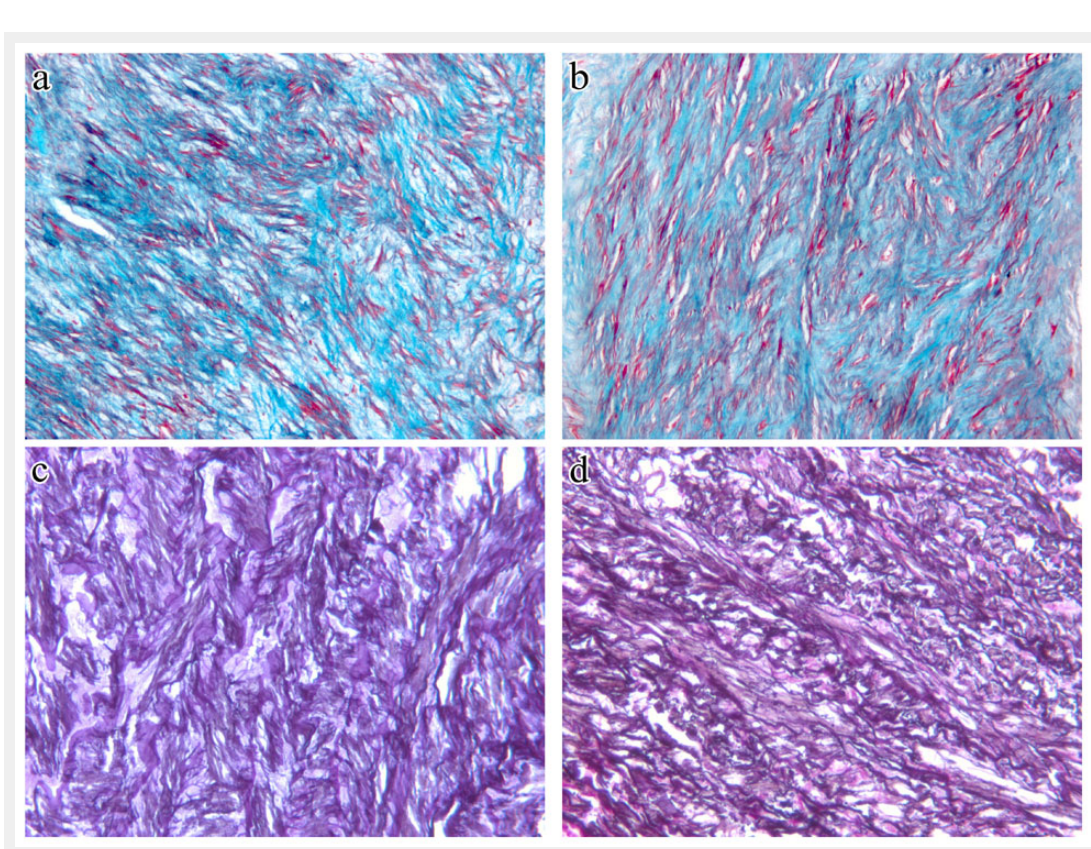
Representative sections of aorta stained with Masson’s demonstrate increased collagen and disorganisation of smooth muscle and collagen in the media of the aortic wall of hypertension patients (a), as compared with non-hypertension patients (b). Collagens are stained green and smooth muscle is stained red. Magnification x200. Representative sections of aorta stained with Weigert’s demonstrate decreased elastin and disorganisation of the elastic network in the media of the aortic wall of hypertension patients (c), as compared with non-hypertension patients (d). Elastins are stained black. Magnification